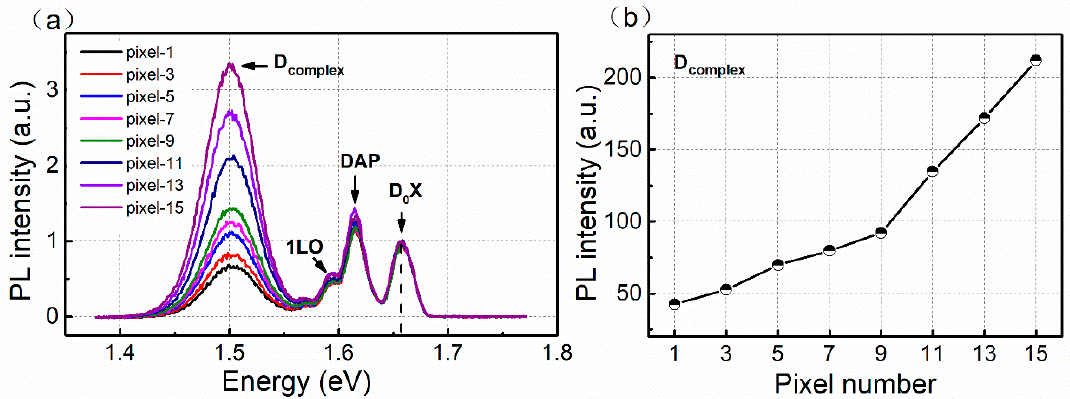
Figure 4. ( a ) Photoluminescence (PL) spectra from the typical pixels with different photon counting performance; ( b ) The values of the D complex peak intensity of the typical pixels.